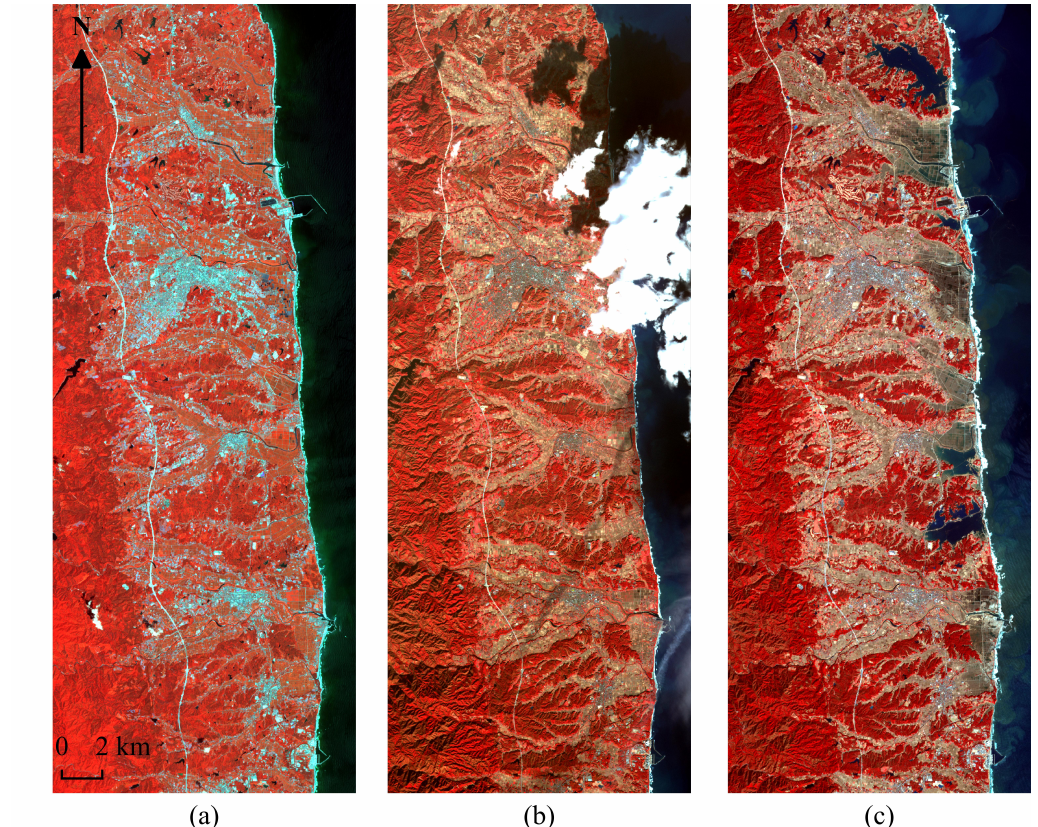
Figure 6. Images taken over the damaged area, ( a ) 7 July 2010, ( b ) 29 November 2010, ( c ) 19 March